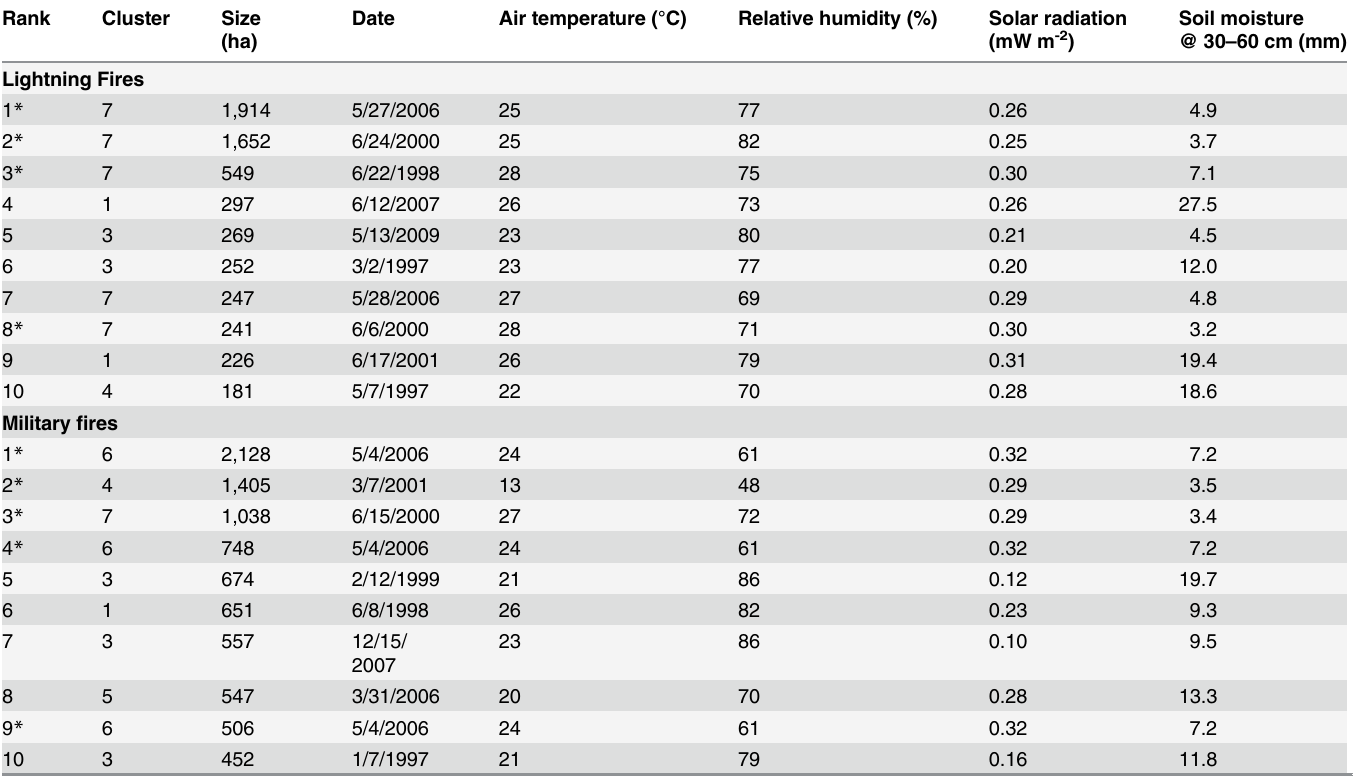
Table 4. Top 10 largest lightning and military fi res, and the weather conditions under which they burned.